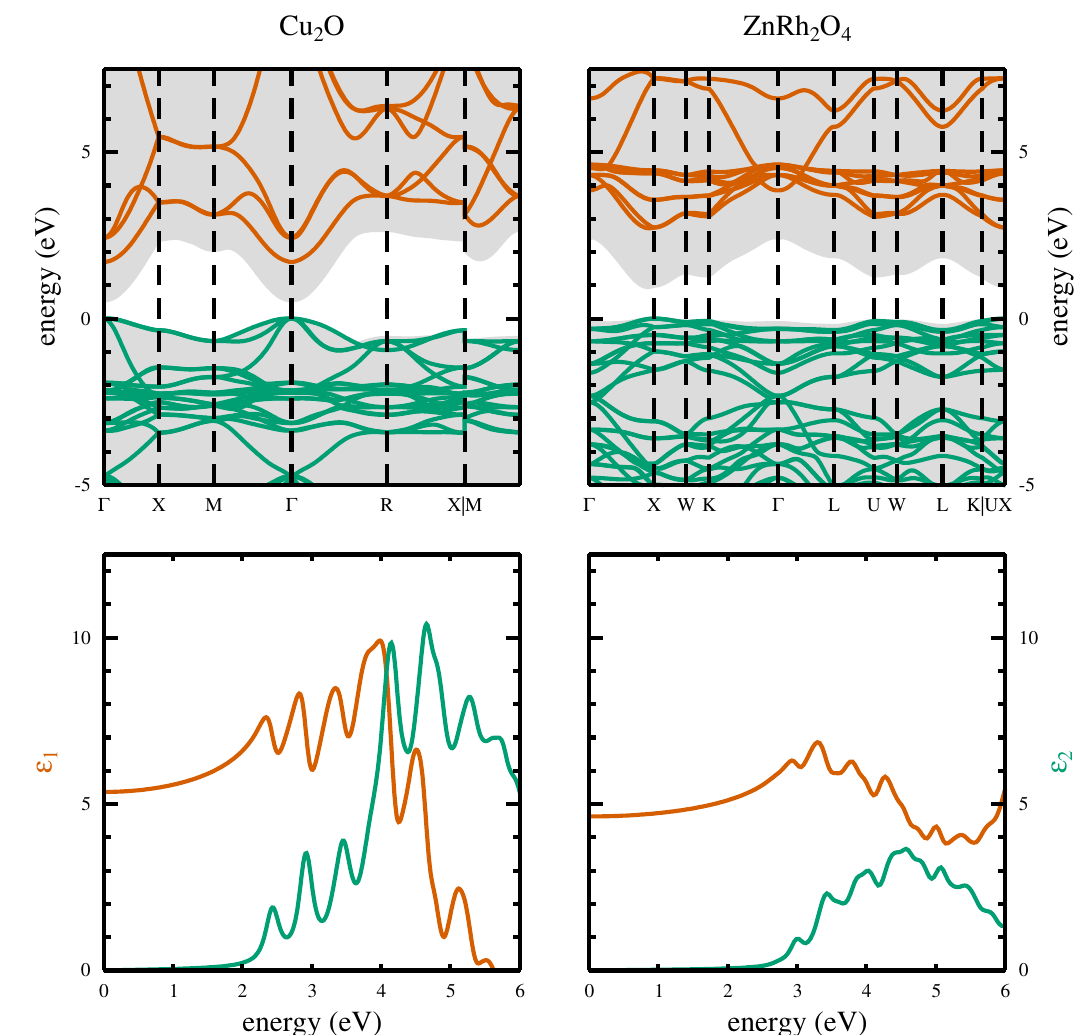
Figure 2. Upper panels : electronic band structures for Cu 2 O (left panel ) and ZnRh 2 O 4 ( right panel ) calculated by means of the self-consistent hybrid exchange and correlation functional scPBE0. Shown are the valence (green) and conduction bands (red), whereas the shaded grey backgrounds indicate the results for the SCAN exchange and correlation functional. Energies are in electron volt (eV) and the valence band maximum is set to zero. Lower panels : optical properties for Cu 2 O ( left panel ) and ZnRh 2 O 4 ( right panel ). Shown are the ε 1 real (red) and ε 2 imaginary (green) parts of the dielectric functions, calculated by means of the scPBE0 exchange and correlation